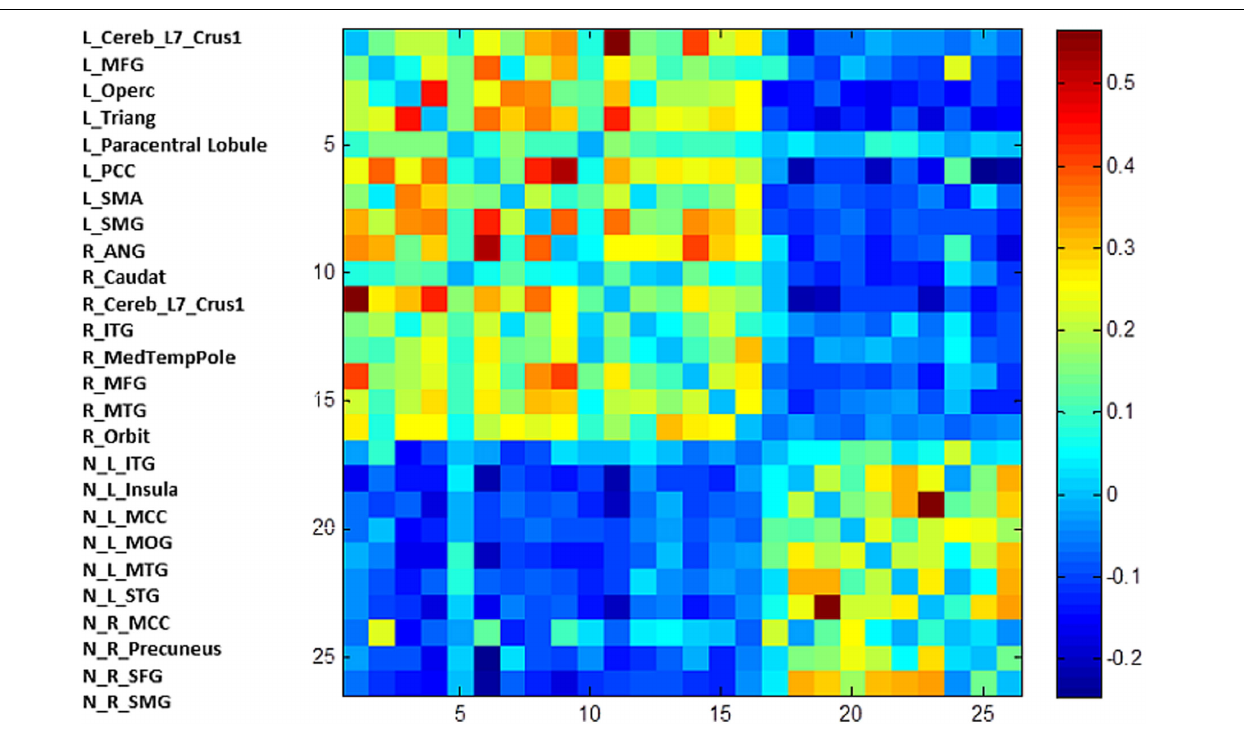
FIGURE 4 | The unthresholded adjacency matrix of the RSN. The figure shows the adjacency matrix of the 25 positively and negatively correlated nodes. L, left; R, right; N, negative; Trinang, pars triangularis; MFG, middle frontal gyrus; PCC, posterior cingulate gyrus; SMA, supplementary motor area; SMG, supramarginal gyrus, Operc, pars